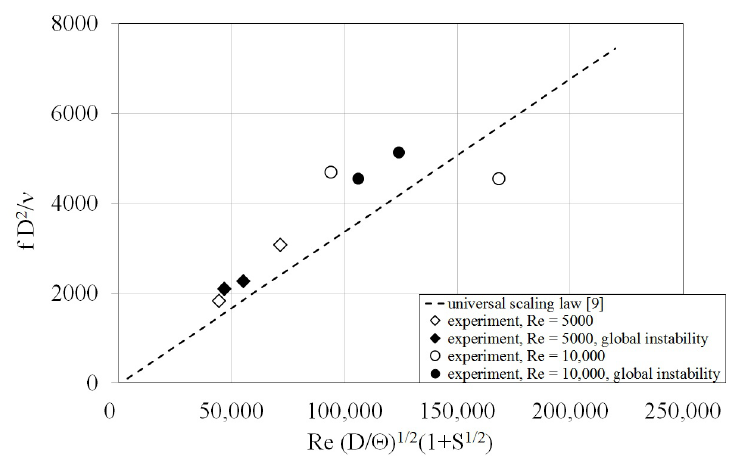
Figure 18. Experimental results vs. universal scaling law